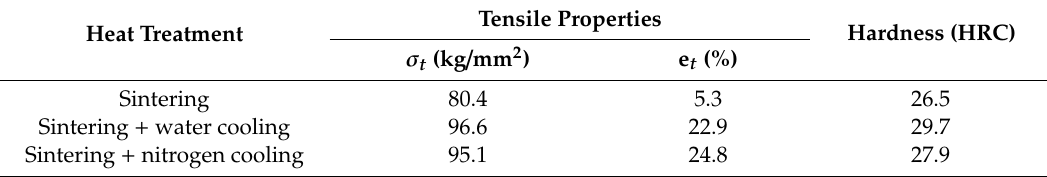
Table 1. Mechanical properties of sintered tube after heat treatment.